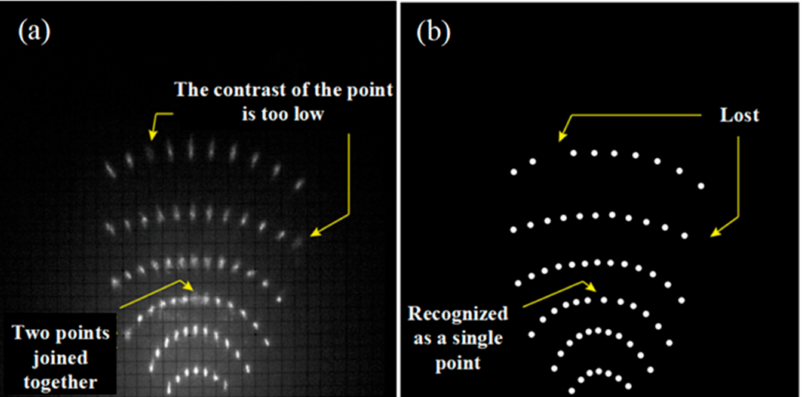
Figure 8. The phenomena of “missing points”. ( a ) A reflection image taken in the 70 current test; ( b ) The image processing result of ( a